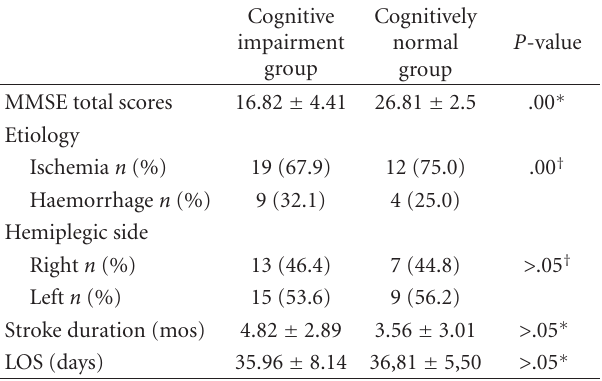
Table 2: Stroke related characteristics of the patient